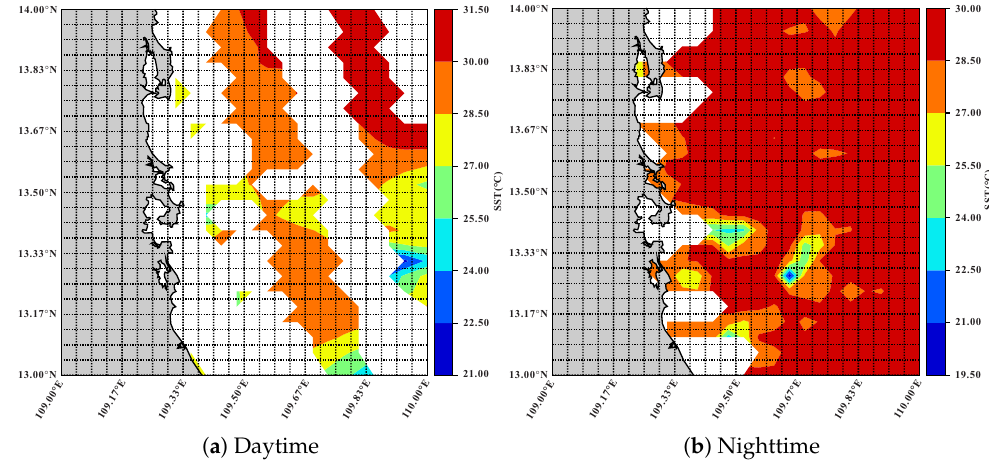
Figure 3. The spatial distribution of SST-SOUTH dataset on Jul 17, 2021, where the white areas have no data, and the gray areas are